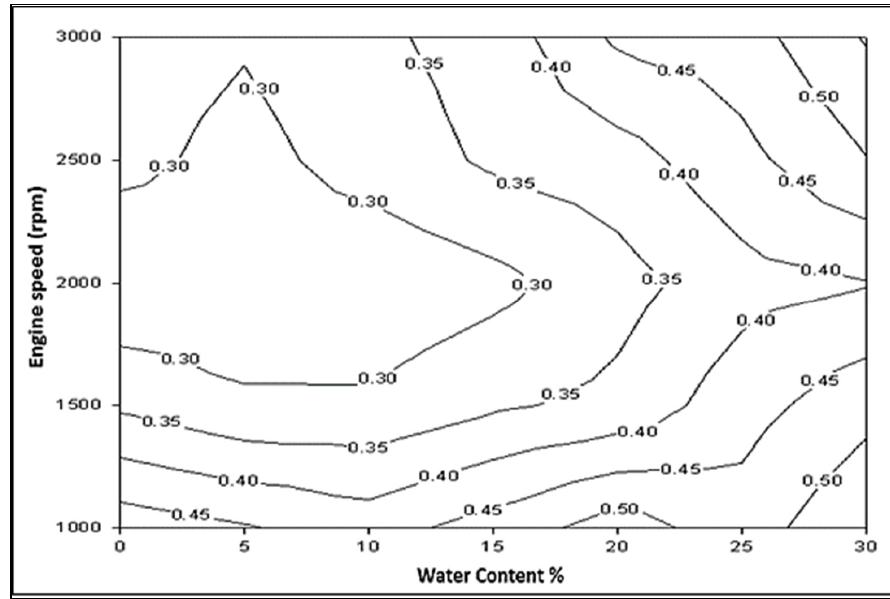
Figure 10. BSFC (kg/kW ∙ h) for pure diesel and different water addition to diesel fuel.